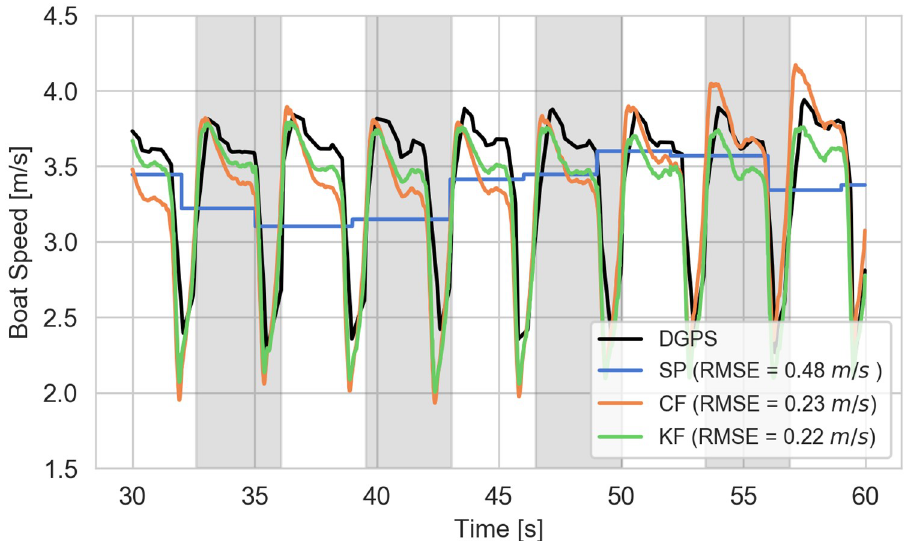
Fig 14. Example boat speed estimates. The figure indicates the speed as a function of time for the last 30 s of the elite 16NW trial as estimated by the smartphone, complementary filter, and Kalman filter. The alternating gray and white sections indicate each stroke. The reported RMSE values are relative to the DGPS computed speed shown in black. Each RMSE v is calculated at the 100 Hz accelerometer sampling rate.